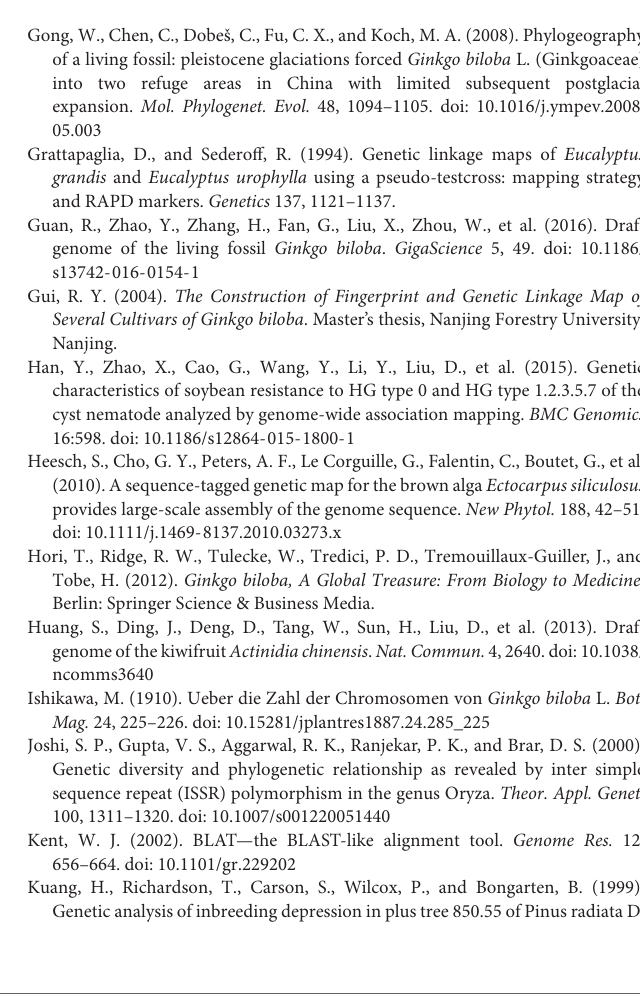
FIGURE S2 | Haplotype map for each linkage group by each individual. Different individuals in rows were spaced by blank line, markers on the right were listed coordinate to the order in the linkage map. The swift of green and blue colors indicates the recombination events. The gray color represents missing marker. FIGURE S3 | Heat map of each linkage group by pair-wise markers. Each cell represents the recombination rate of pair-wise markers. Yellow color indicates strong linkage, and changes of colors from yellow to purple indicating weaker linkage. TABLE S1 | The number of loci and all the mapped markers (including bins and singletons) by sliding 10 cM windows along each LG. TABLE S2 | The list of segregation distorted SLAFs. TABLE S3 | The distribution of the segregation distorted SLAFs in each